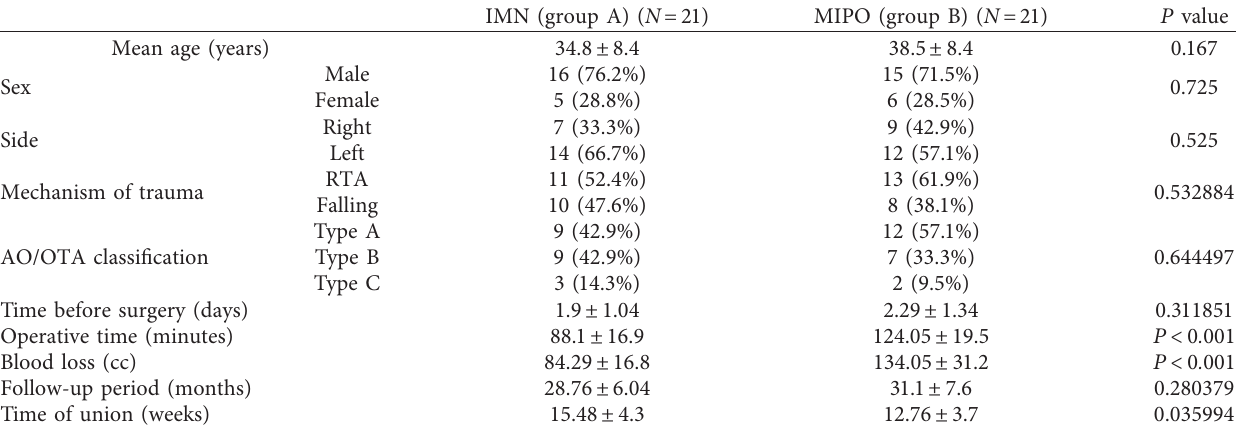
Table 1: The demographic and intraoperative data of the groups